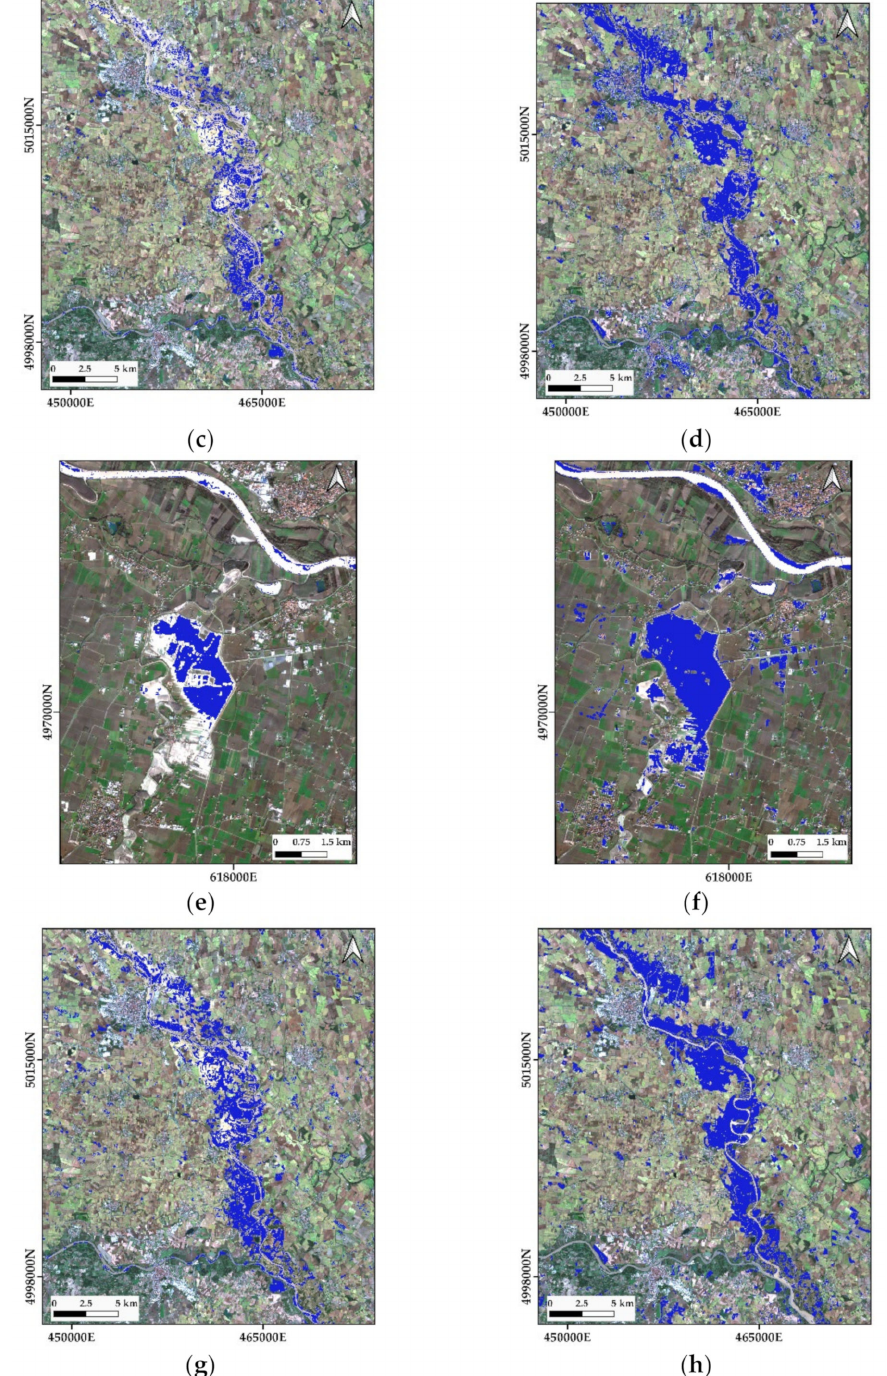
Figure 6. Flood maps obtained by unsupervised methods for the case studies Enza and Sesia rivers. The Otsu results of VV for the case study of ( a ) Enza river (in 2017) and ( c ) Sesia river (in 2020) and of NDWI for the case study of ( b ) Enza river (in 2017) and ( d ) Sesia river (in 2020). The CThS results of VV for the case study of ( e ) 2017 and ( g ) 2020 and of NDWI for the case study of ( f ) 2017 and ( h ) 2020. Pixels classified as water are displayed in blue color, overlaid onto the RGB true color composite of flooding date. The backscatter data on 7 December 2017 and 27 September 2020 as well as the MS data on 24 October 2017 and 9 August 2020 were used to map the permanent water body areas by each method